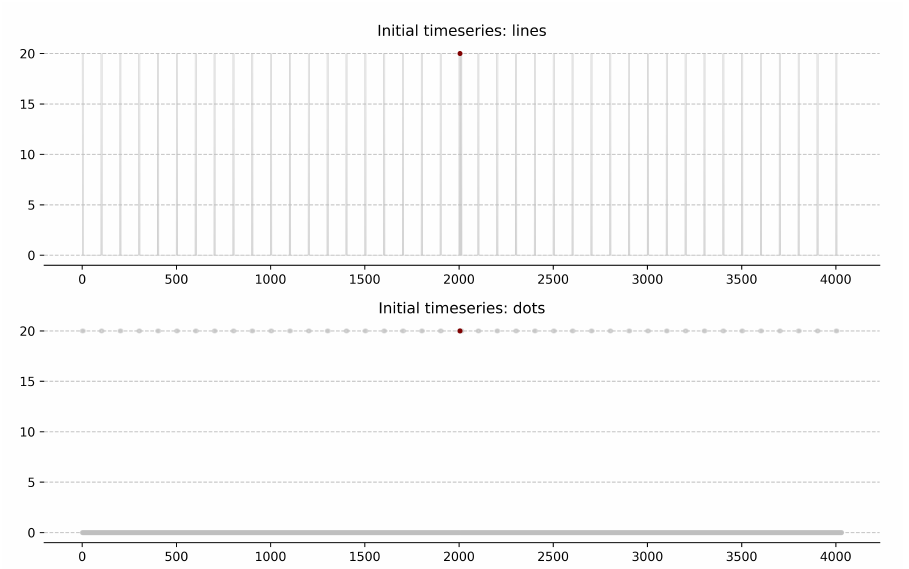
Figure 11. Numenta Anomaly Benchmark spike density anomaly found with anomaly likelihood threshold